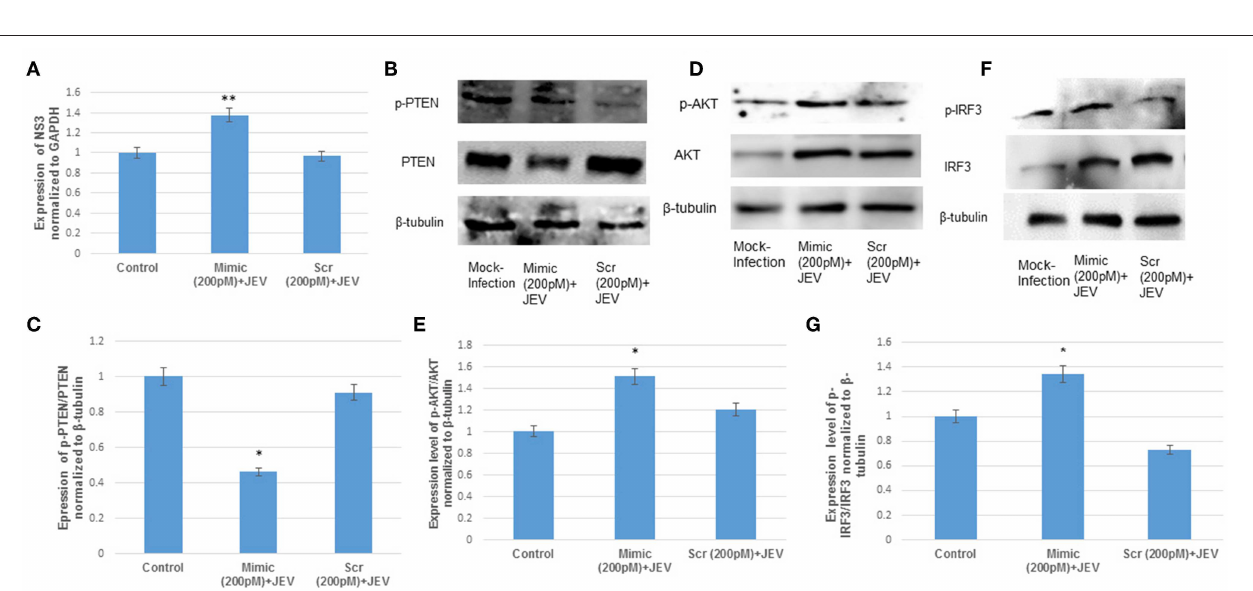
FIGURE 5 | The over-expression of hsa-miR-374b-5p during JEV infection. (A) qRT-PCR to confirm the JEV infection post transfection by quantifying the JEV NS3 levels. (B) Expression levels of p-PTEN/PTEN suppress by 50% during over-expression of microRNA mimics post JEV infection. (C) Densitometry of p-PTEN/PTEN. (D) The p-AKT/AKT expression up-regulates by 1.4-folds during over-expressing the microRNA mimics and JEV infection. (E) Densitometry plot of p-AKT/AKT. (F) The p-IRF3/IRF3 expression up-regulates up to 1.3-fold during over-expressing the microRNA mimics and JEV infection. (G) Densitometry plot of p-IRF3/IRF3. The data are shown as mean ± S.E from three independent experiments ( n = 3 ). The fold change is significant where * denotes P < 0.05, ** denotes P < 0.01, *** denotes P < 0.001.